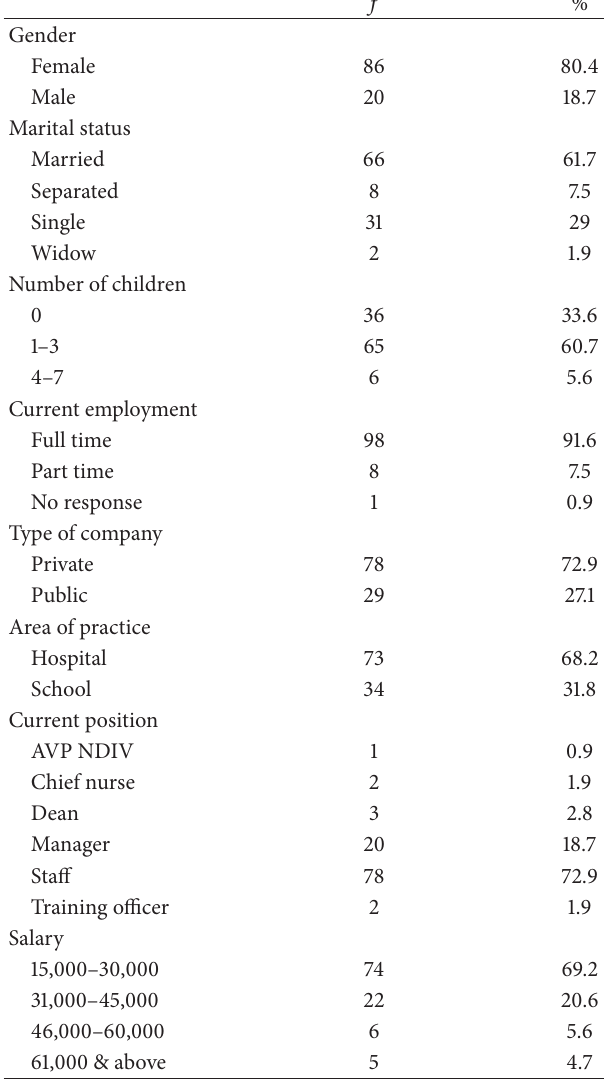
Table 1: Demographic profile of the respondents ( 𝑛 = 107